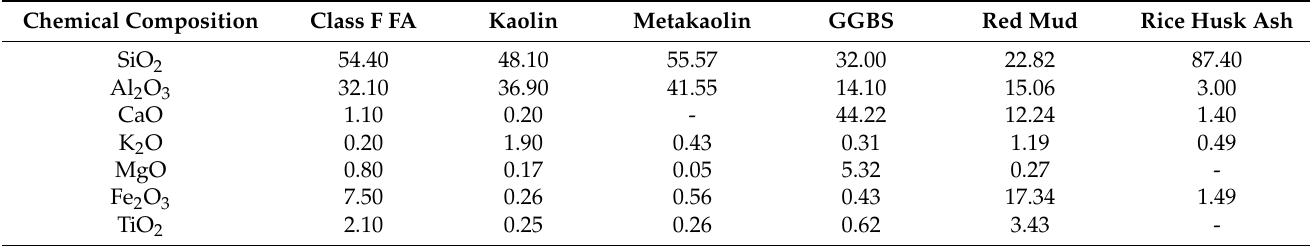
Table 2. Chemical composition of aluminosilicate precursors that have been used by previous researchers